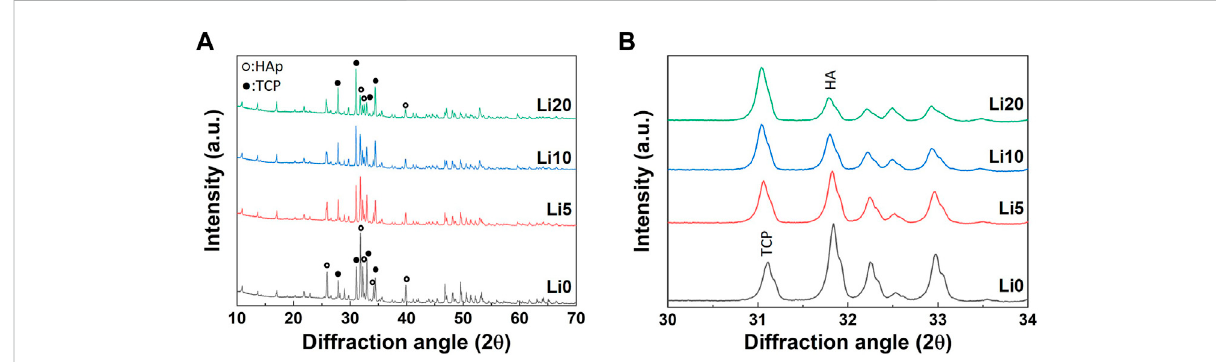
FIGURE 1 The pure BCP and Li-BCP powders after calcined at 1,000 ° C; (A) XRD patterns and (B) magni fi ed XRD patterns for the (2 1 1) and (0 2 10) peak corresponding to HAP and B-TCP phase,